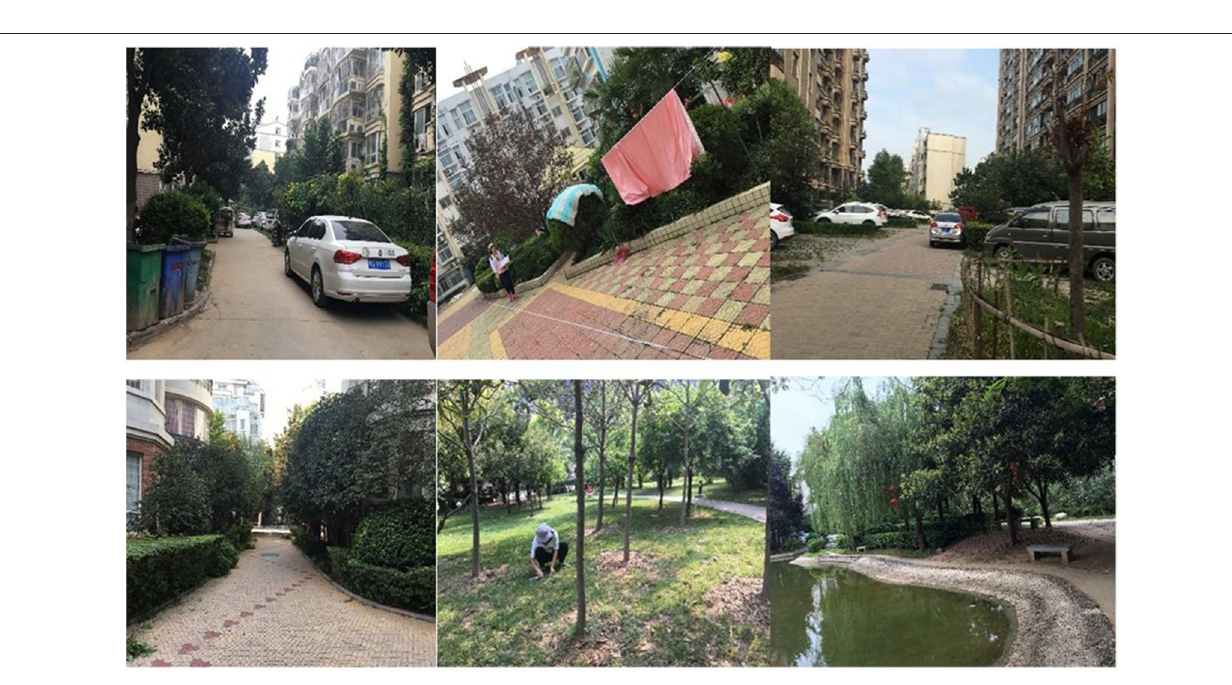
FIGURE 8 | Differences in the management level between the residential communities with the lowest (above) and highest (below) satisfaction on the cultural ecosystem services (CES) in green